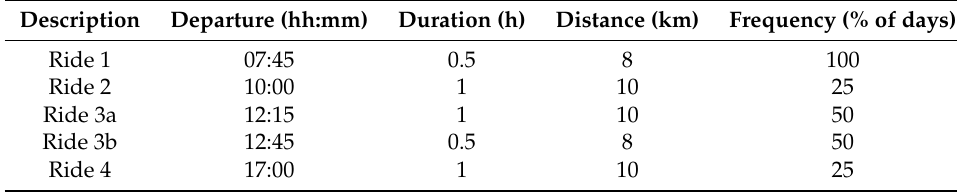
Table A3. Secondary EV schedule for a